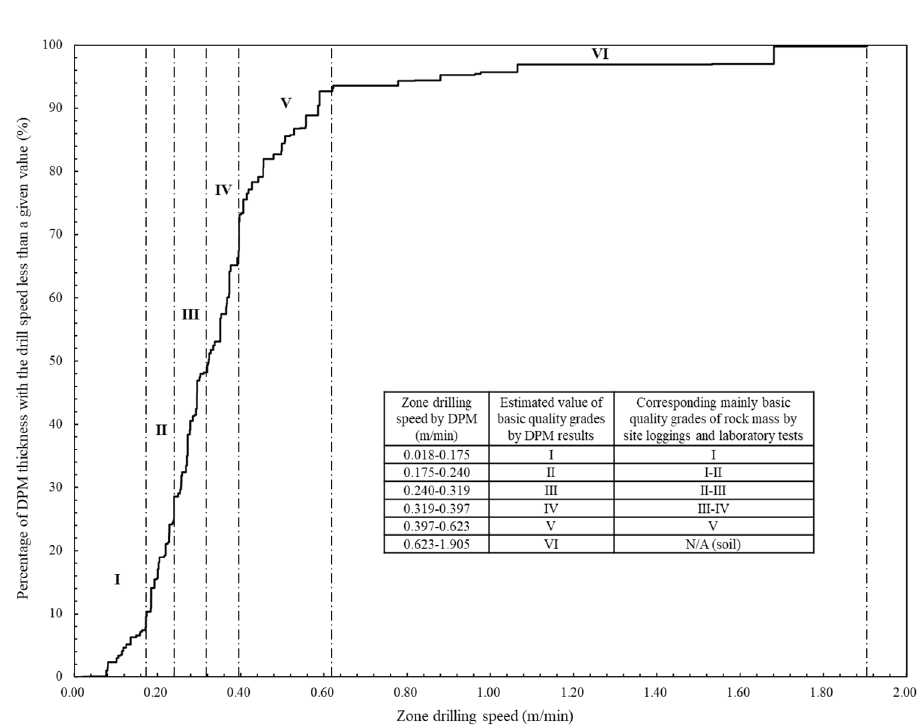
Figure 11. Distributions of the digitalization zone thickness with drilling speed ( RQD DPM ) for statistically profiling the geomaterial